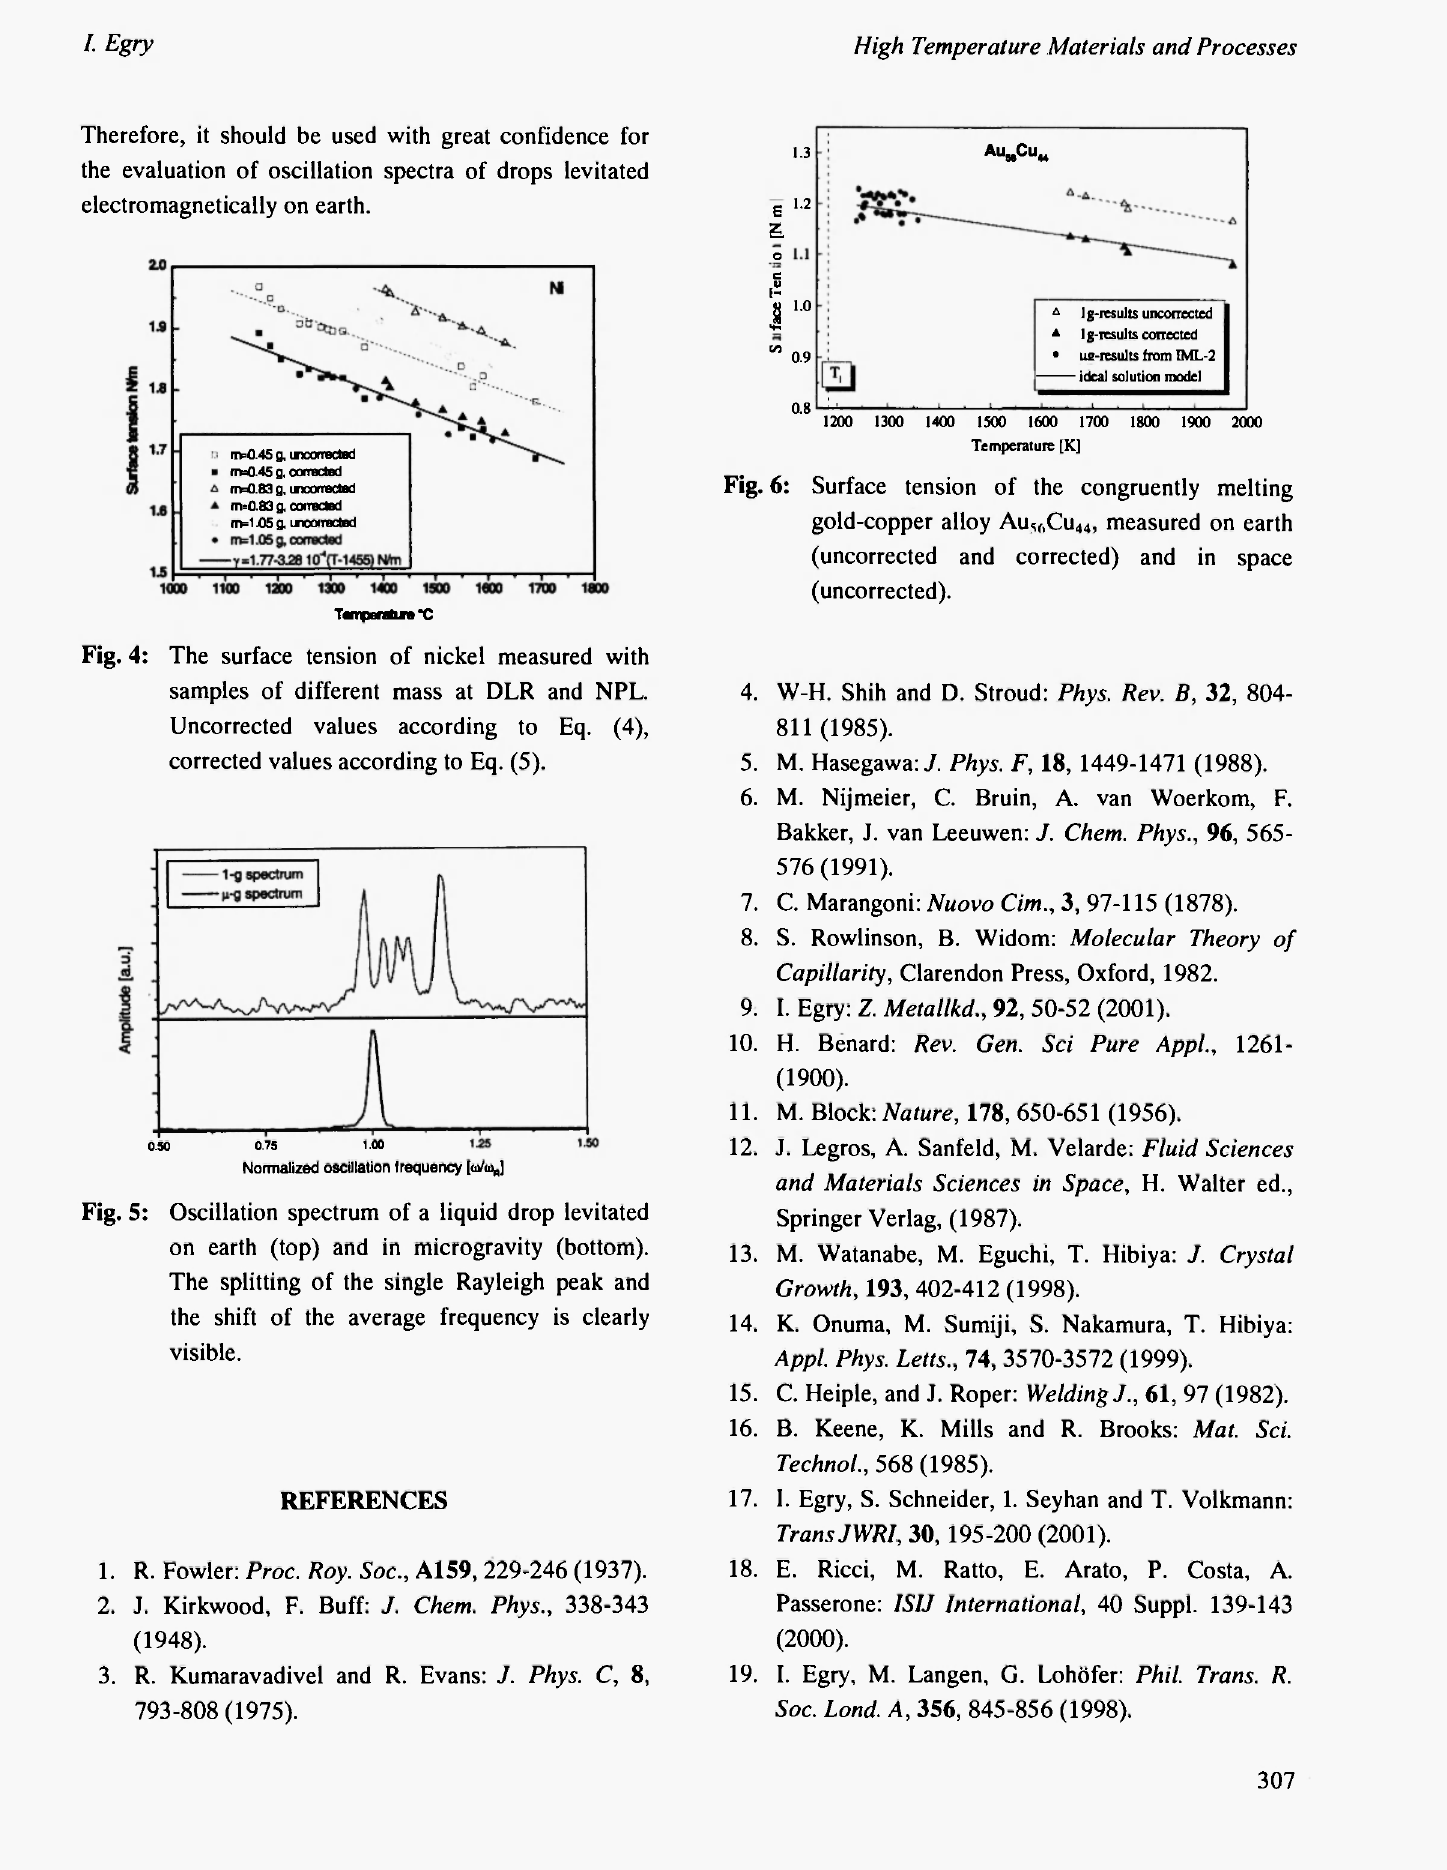
Fig. 6: Surface tension of the congruently melting gold-copper alloy Au v ,Cu 44 , measured on earth (uncorrected and corrected) and in space